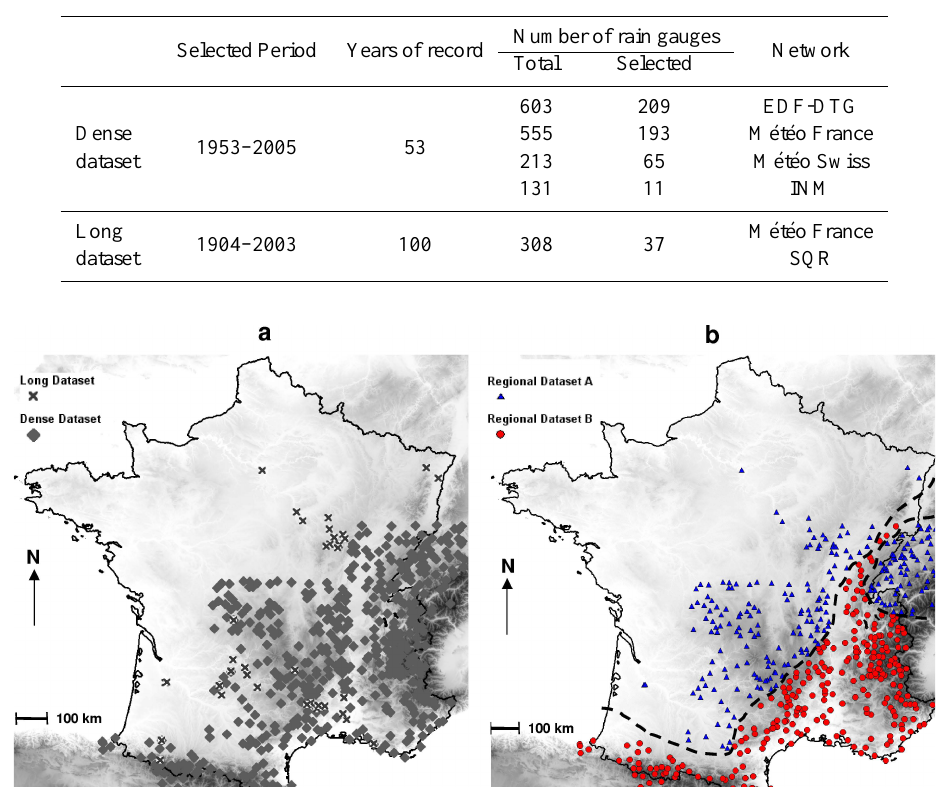
Table 2. Characteristics of the rainfall data sets.